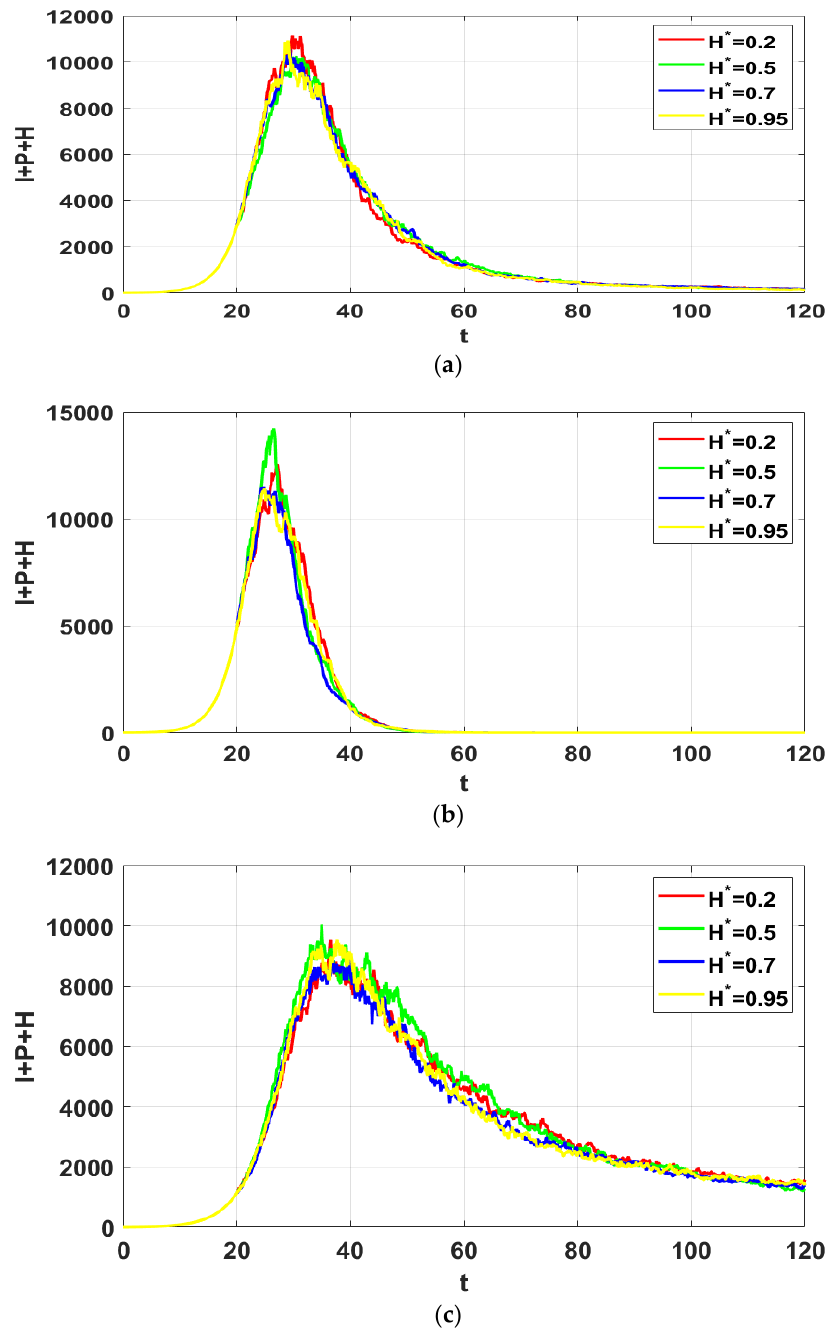
Figure 11. Numerical simulation for system (14–16) at different H ∗ , σ 1 = σ 2 = σ 3 = 0.01, σ 4 = σ 5 = σ 6 = σ 7 = σ 8 = 0.1, and ( a ) α = 0.9, α 1 = 0.87, ( b ) α = 1, α 1 = 1, ( c ) α = 0.75, α 1 = 0.75.